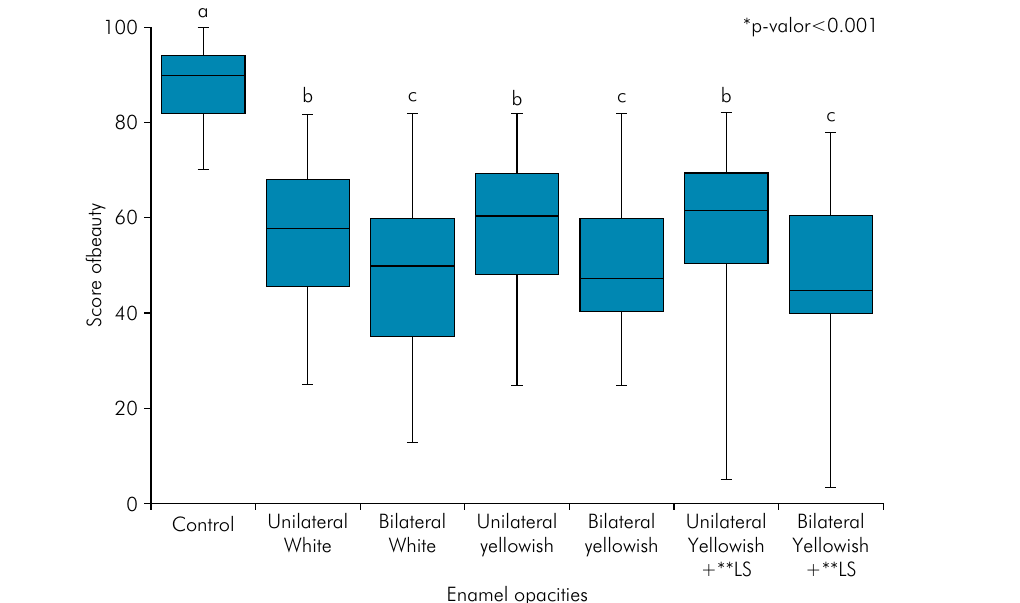
Figure 3. Social judgment score according to the enamel opacities. Rectangle height represents quartiles 1 and 3; line cutting the rectangle represents the median; the semi-quarters connect quartiles 1 and 3 to the minimum and maximum values. *Friedman test (different a, b, c, d, e, f letters in rows indicate the statistical difference in opacity change according to the Wilcoxon test); **Opacities with loss of